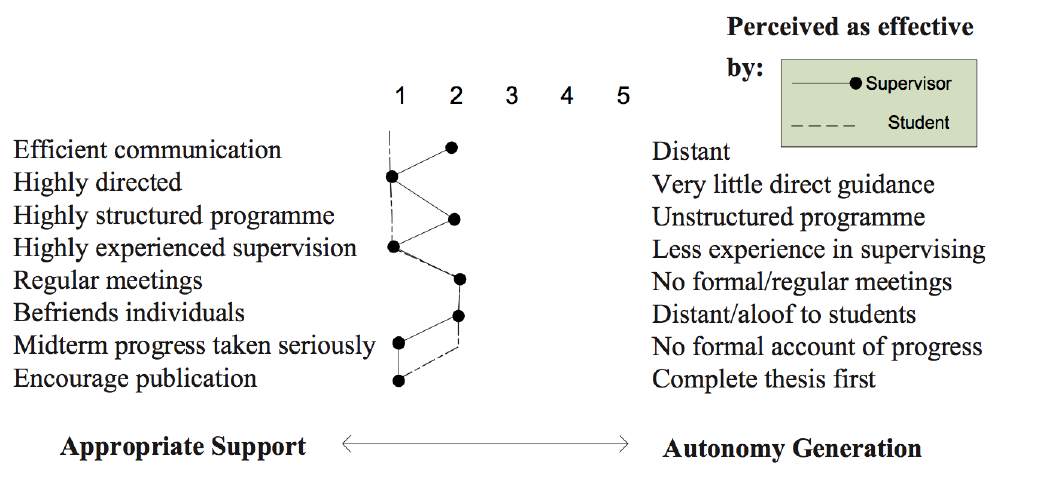
Figure 4 Initial rating (i.e. topic definition)